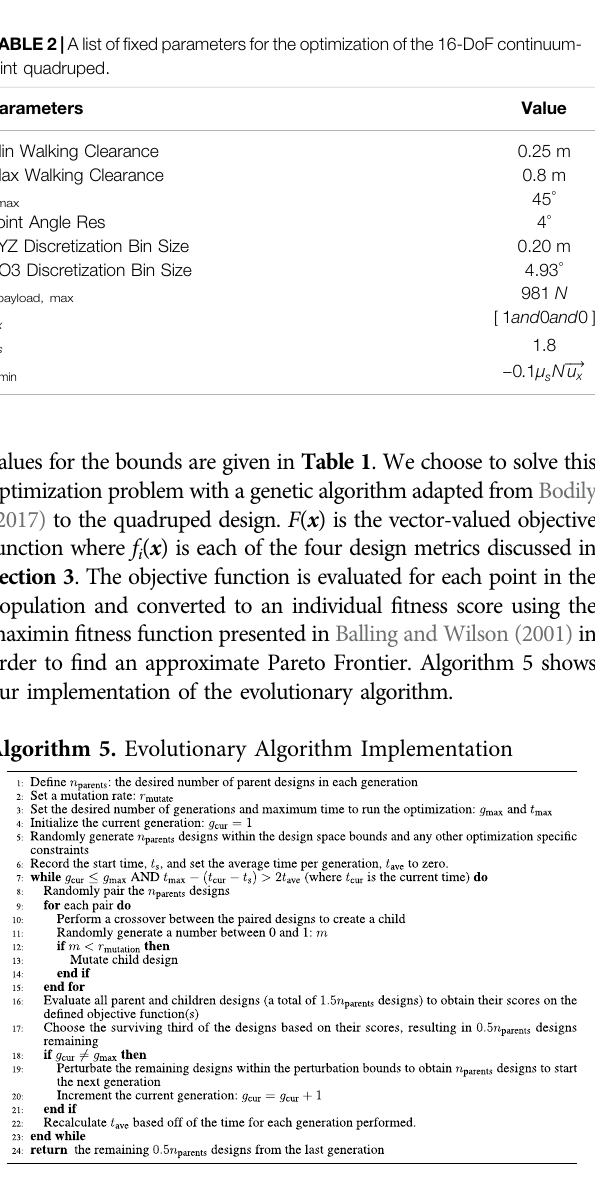
TABLE 3 | Optimization results for four-DoF quadruped. Values marked by * indicate values that were kept constant for the particular optimization. Metric w start